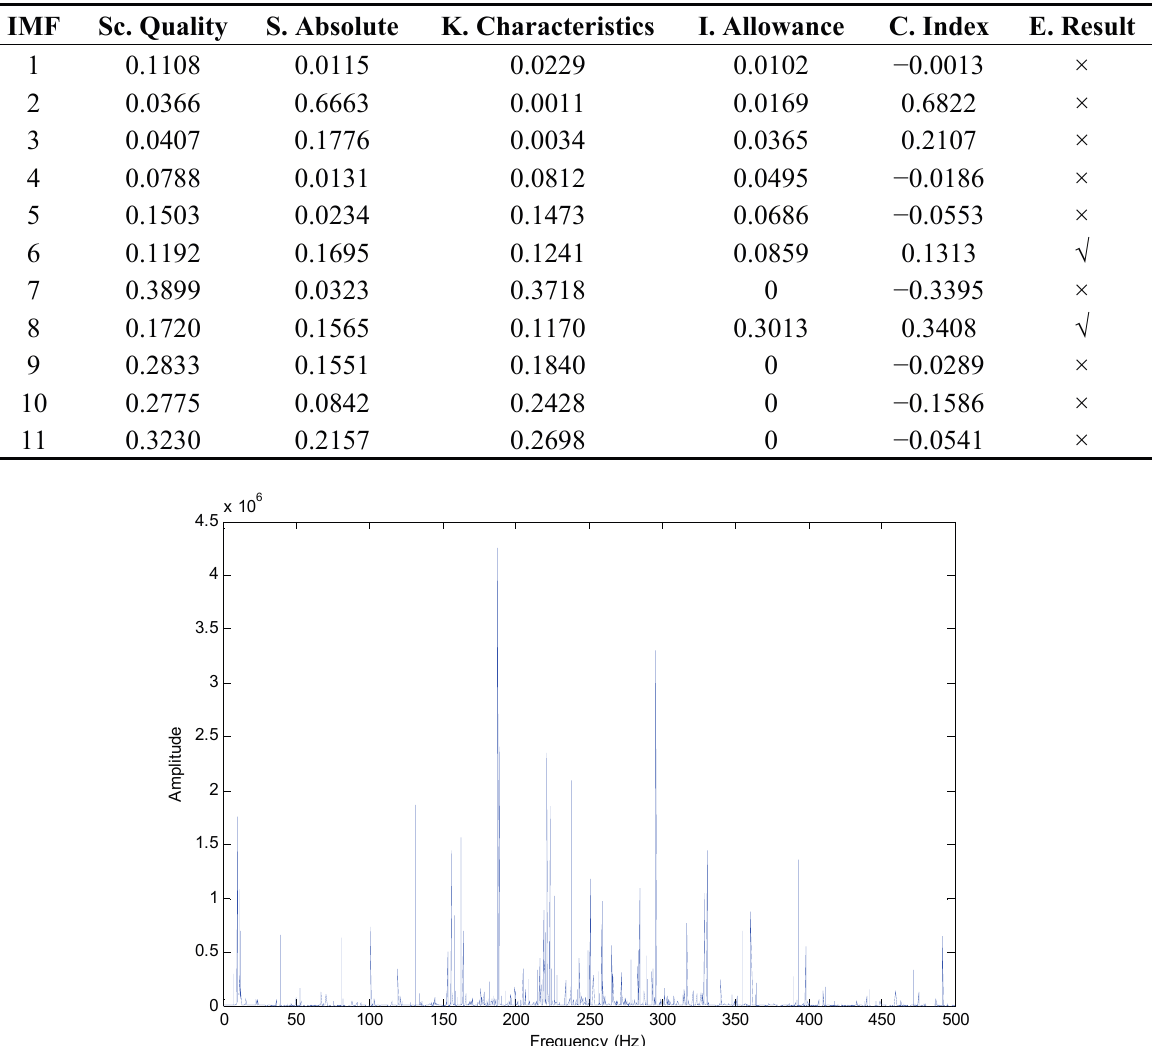
Figure 10. Hilbert marginal spectrum of selected IMFs for the undamaged axle bearing vibration